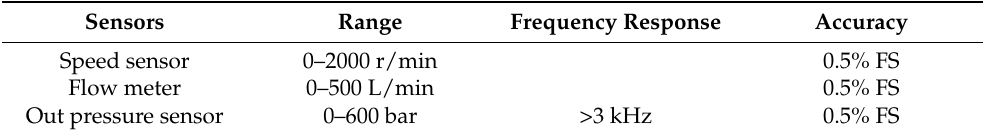
Table 3. Main sensors and equipment descriptions.